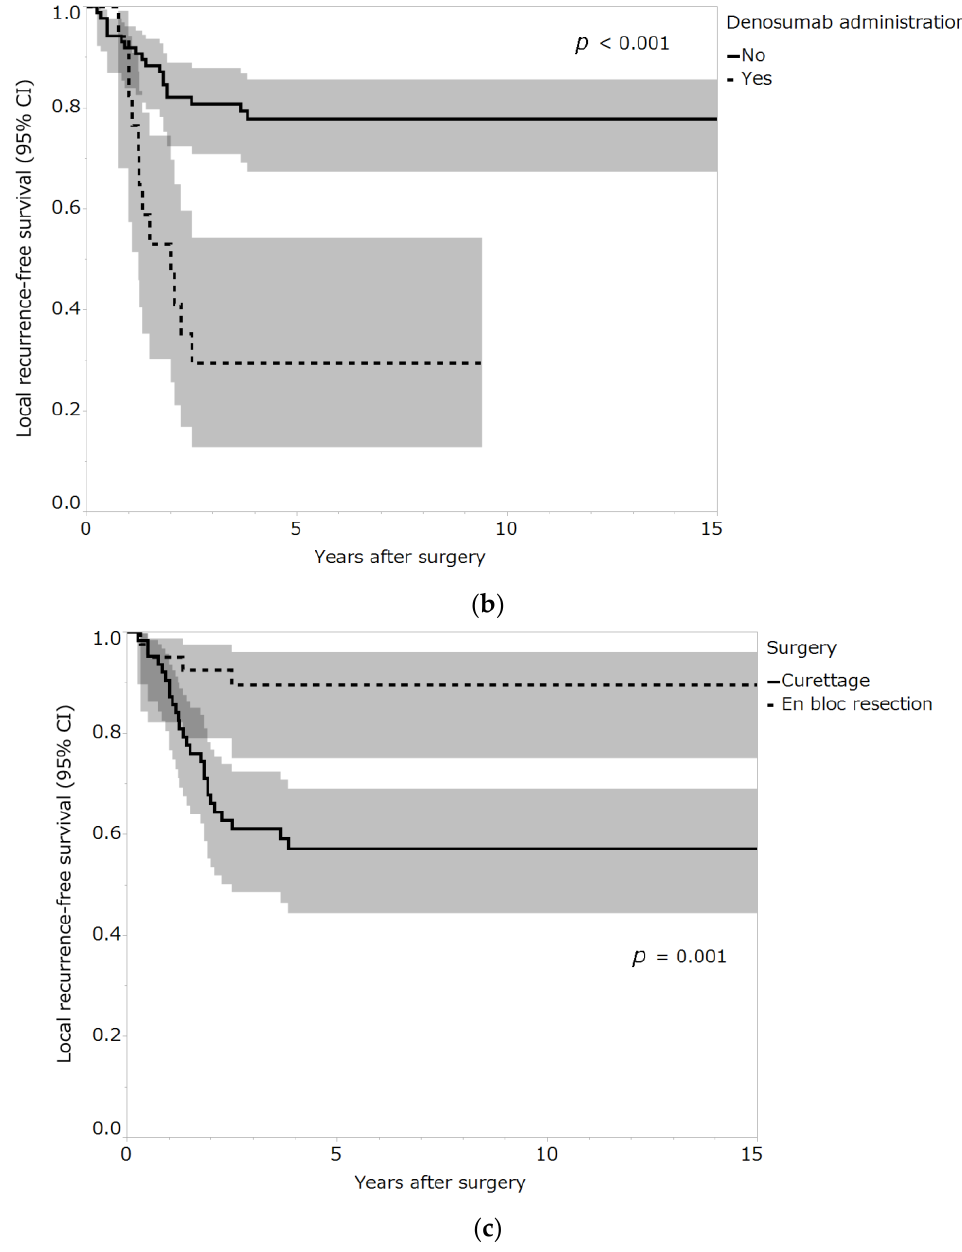
Figure 2. ( a ) Local recurrence — free survival rates of patients by tumor site. Shading around the curves represents the 95% confidence interval (CI). ( b ) Local recurrence — free survival rates of patients by denosumab administration. Shading around the curves represents the 95% CI. ( c ) Local recurrence — free survival rates of patients by the surgical method. Shading around the curves represents the 95% CI.